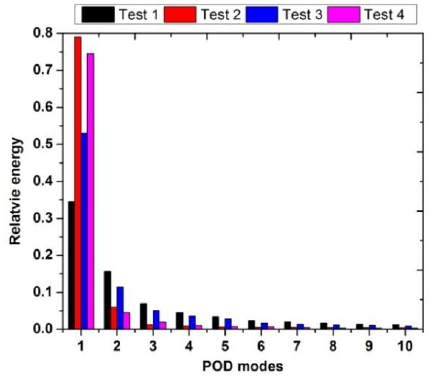
Figure 8. Comparative characterization of relative energy of first 10 modes at different voltage amplitudes and standoff distances.